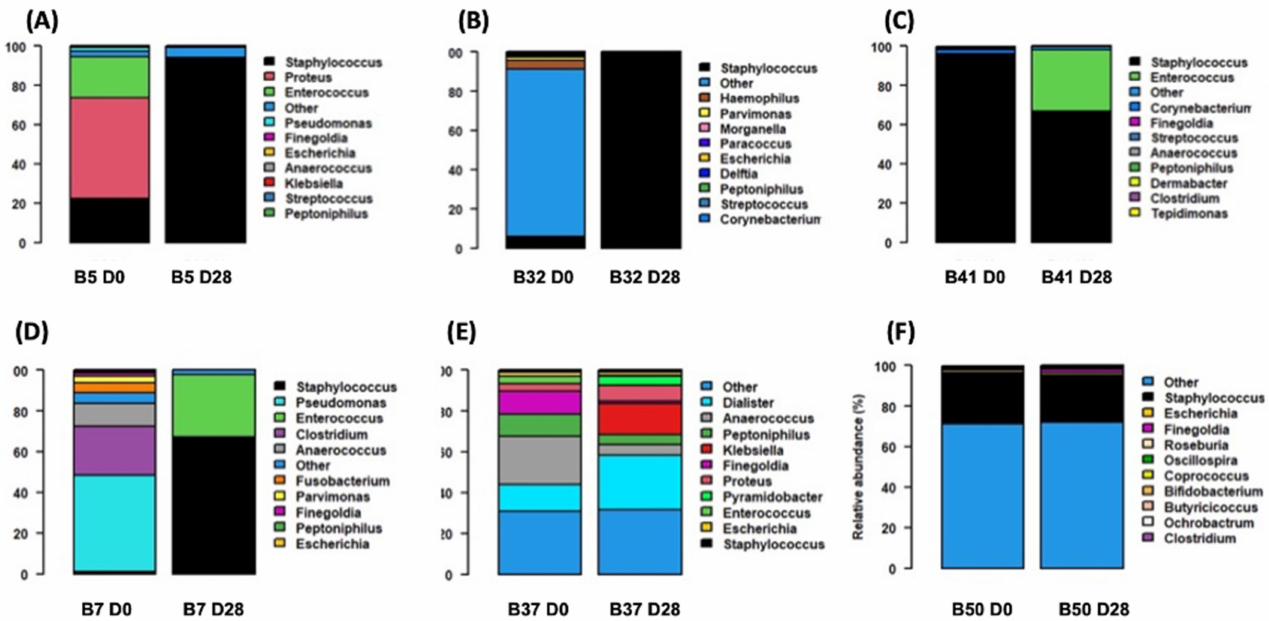
Figure 3. Relative abundance of the 12 top bacterial species from decubitus PU for each biopsy at D0 and D28. At the top, B5 ( A ), B32 ( B ), B41 ( C ) are biopsies sampled from PU that improved at D28. At the bottom, B7 ( D ), B37 ( E ) and B50 ( F ) are biopsies sampled from PU that worsened at